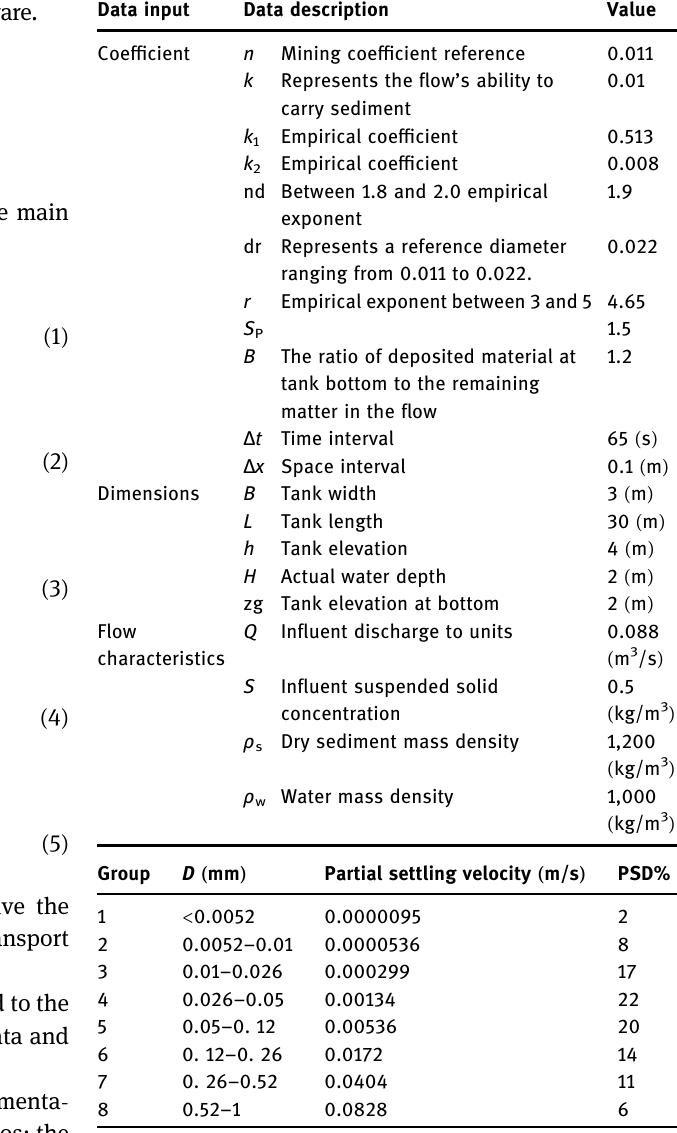
Table 1: Data form operational model [ 7